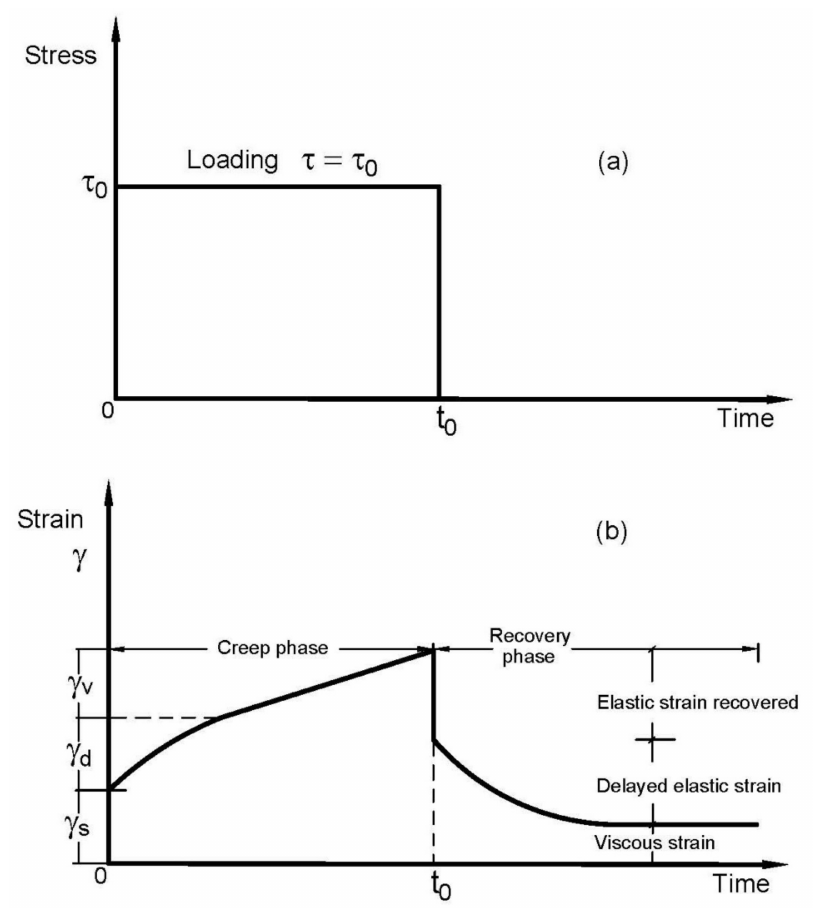
Figure 1. Viscoelastic material curve. ( a ) Loading mode; ( b ) Creep and recovery